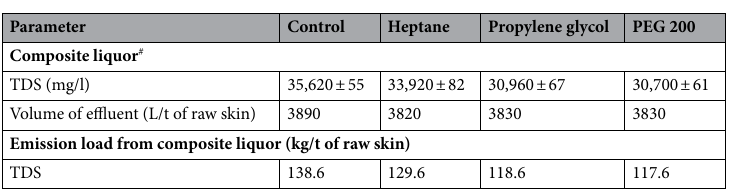
Table 2. Composite liquor analysis for control and experimental leather processing. # Liquor collected up to chrome tanning excluding soak liquor.